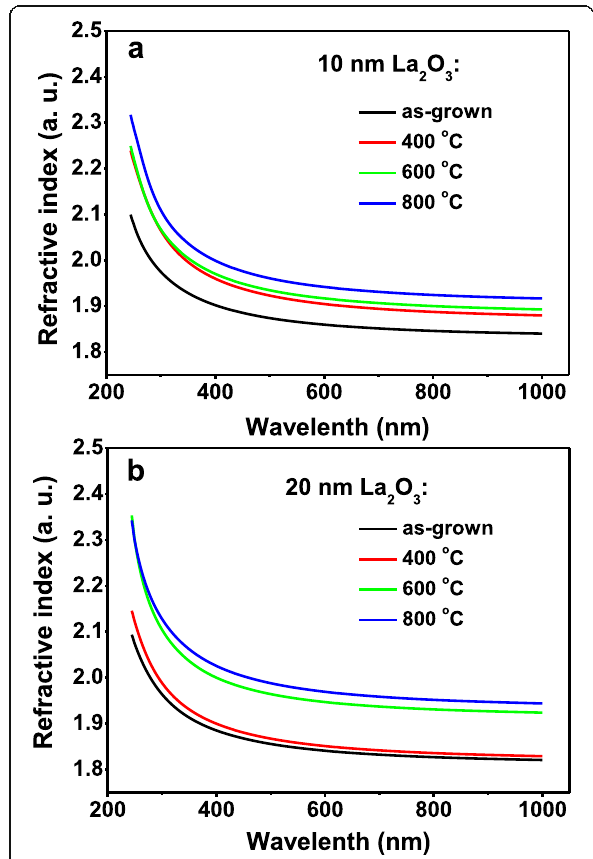
Fig. 4 Annealing temperature dependence of refractive index for ALD-La 2 O 3 with different thickness. a 10 nm La 2 O 3 films and b 20 nm La